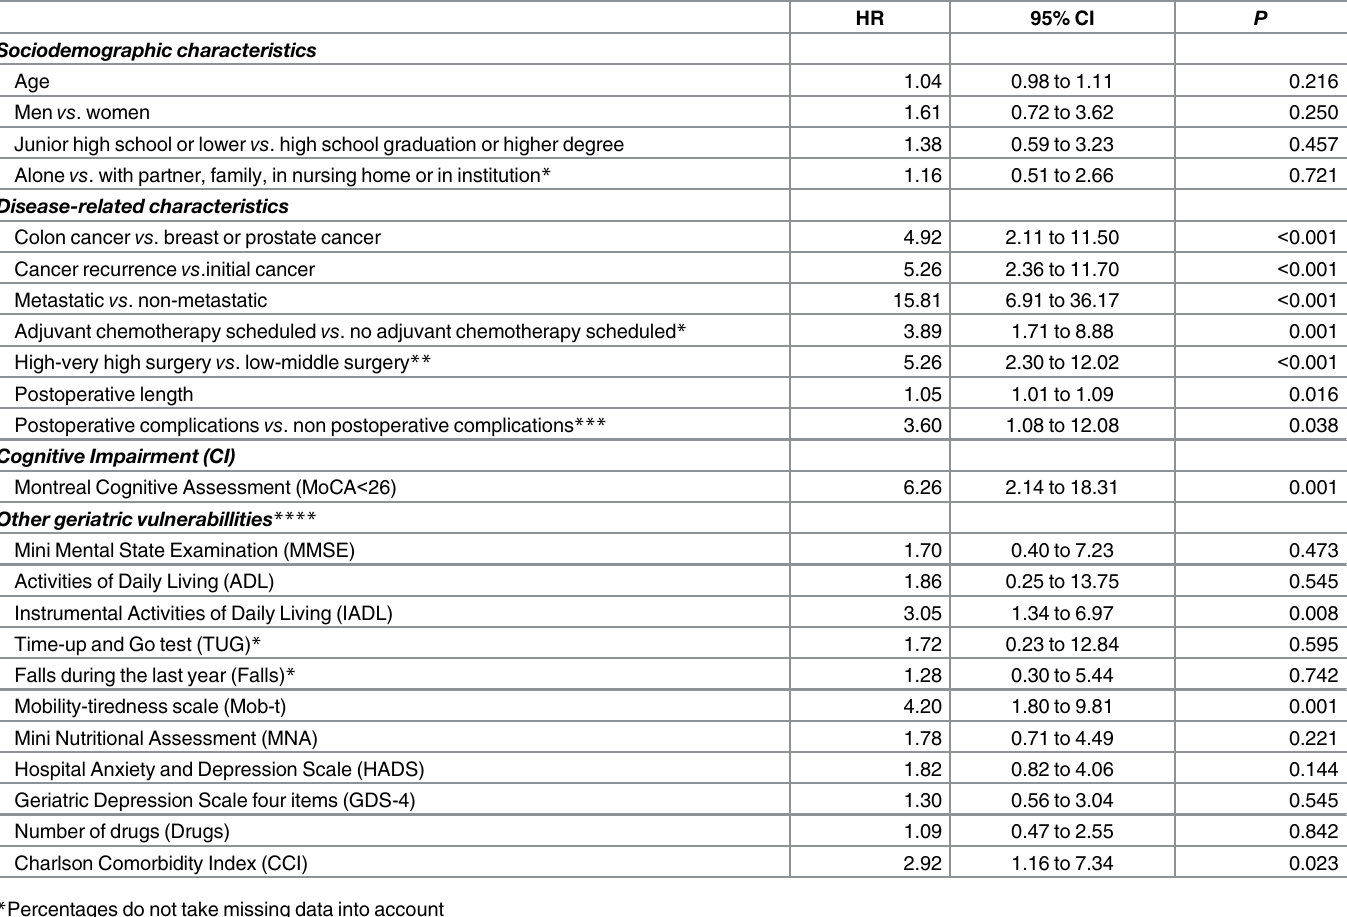
Table 3. Associations between sociodemographic characteristics, disease-related characteristics, Cognitive Impairment (CI) and other geriatric vulnerabilities of older patients at the time of cancer treatment initiation, and two-year survival: Univariate Cox